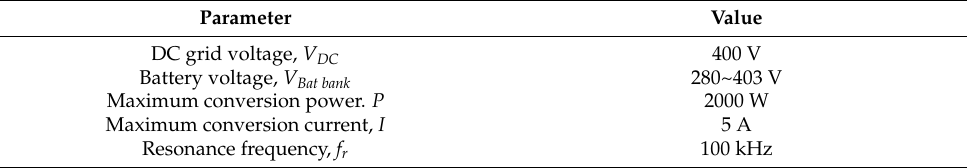
Table 1. Electrical specifications of the fabricated converter.